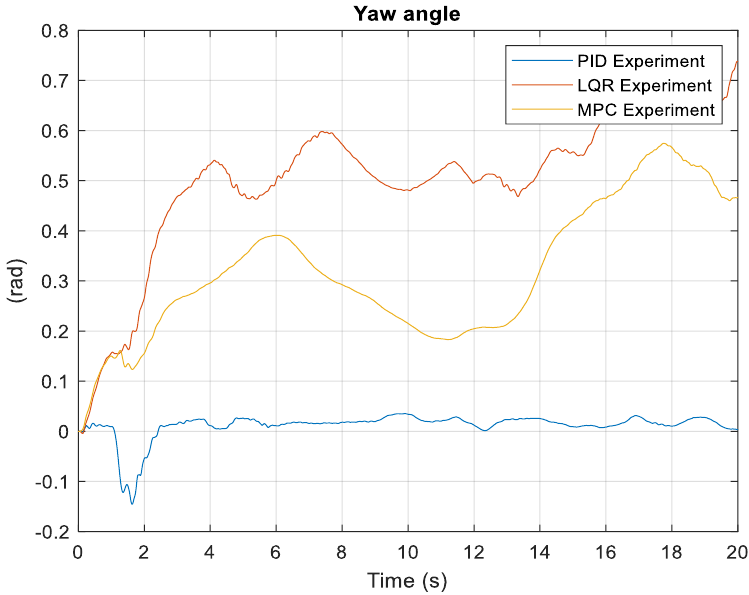
Figure 10. Performance of the controllers for yaw angle in real-time.